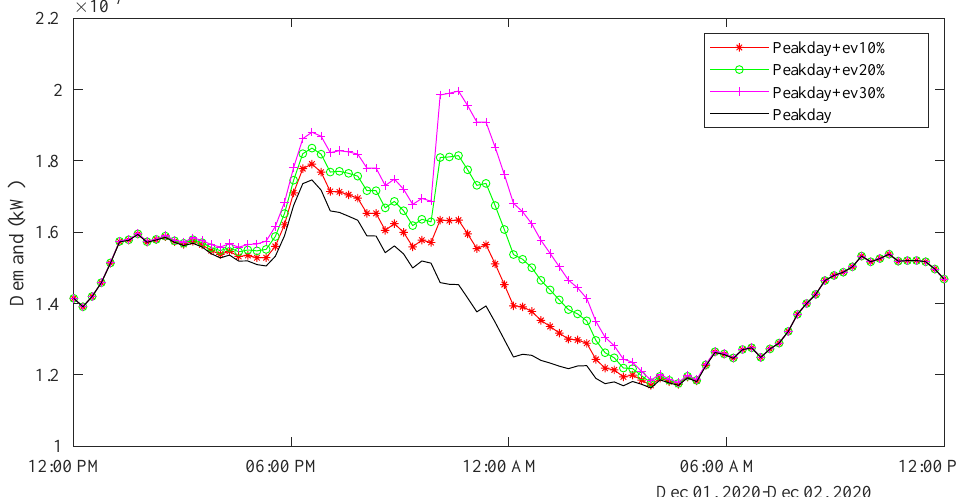
Figure 11. Load demand of the PEA when the TOU pricing policy is applied with T b = 10:00 p.m. and uniform distribution of S i .